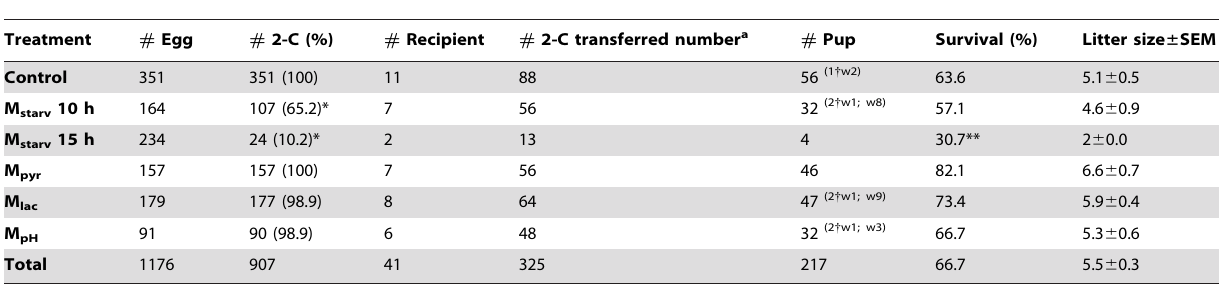
Table 1. Developmental potential of experimental and control eggs.